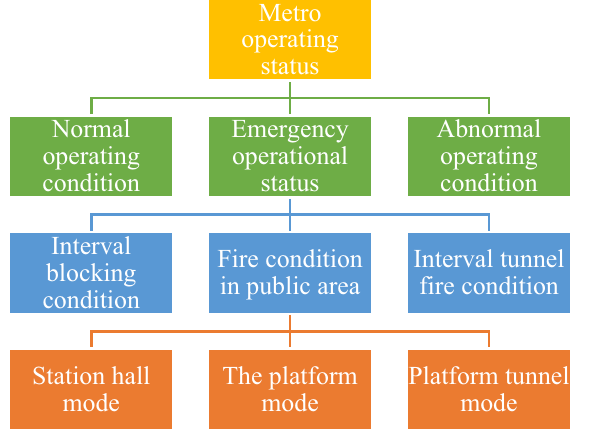
Figure 1. Metro operation